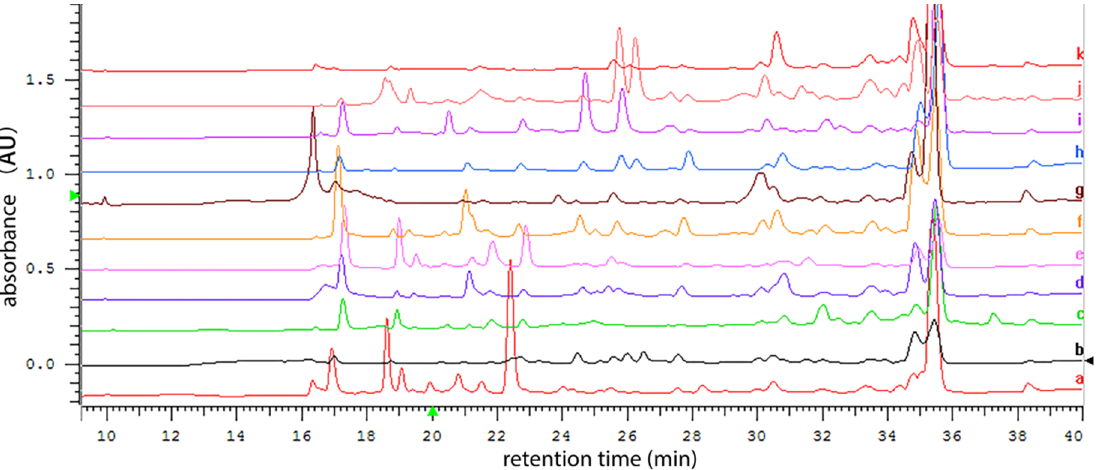
Figure 2. HPLC analysis of the secondary metabolite profile of P2100 cultured in 11 different media. a. YES medium; b. MEB medium; c. CYA medium; d. Czapek +1% tryptone medium; e. GPY medium; f. Czapek +1% yeast extract medium; g. PDB medium; h. Czapek medium; i. Starch